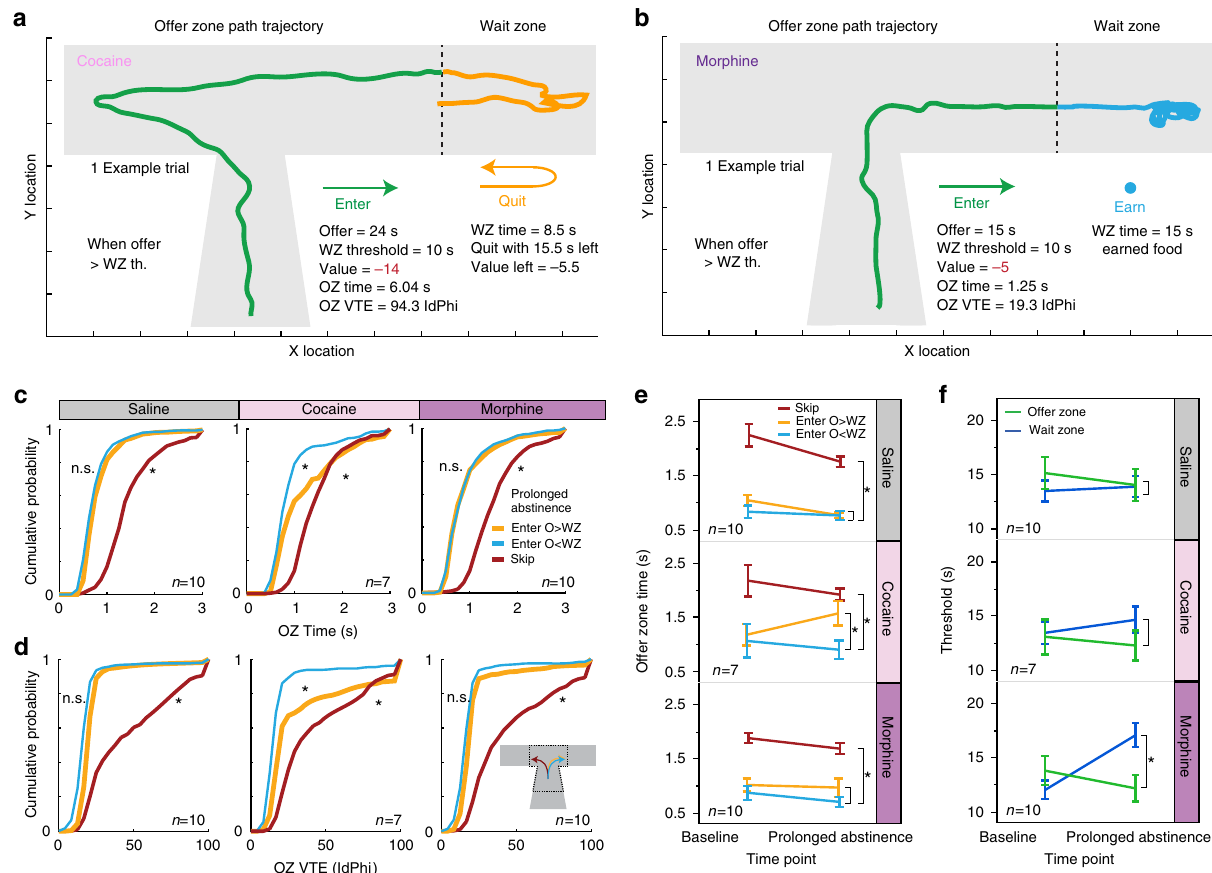
Fig. 3 The effects of prolonged abstinence from repeated drug exposure on choice con fl ict. a , b Example of path trajectory in the offer and wait zones for negatively valued economically unfavorable offers. a A mouse with a history of repeated cocaine exposure initially oriented toward skipping (left) then ultimately re-oriented to enter (right). Capability of quitting was unaltered. b A mouse with history of repeated morphine exposure was less capable of quitting rapidly accepted offers. c , d Cumulative probability distributions of offer-zone time ( c ) and VTE ( d ) for skips as well as enters split by offer value separated by drug-treatment conditions. Both types of enter decisions were rapid compared to skips and indistinguishable from each other for saline and morphine mice (KS tests, not signi fi cant, n.s., P > 0.05). Cocaine mice displayed increased time and VTE before accepting negatively valued offers (KS tests, * P < 0.05). e , f Repeated measures Friedman tests correcting for multiple post-hoc Mann – Whitney tests reveal cocaine-speci fi c changes ( e ) in offer zone deliberation time when entering economically disadvantageous offers and morphine-speci fi c changes ( f ) increasing wait-zone thresholds (* P <